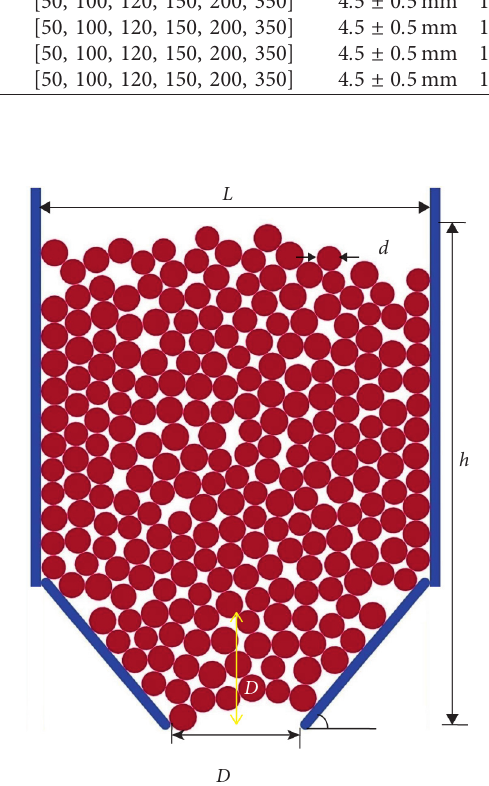
Figure 2: Example of a typical clogging configuration obtained by two-dimensional discrete simulation. Yellow box shows the po- sition where the contact pressure is